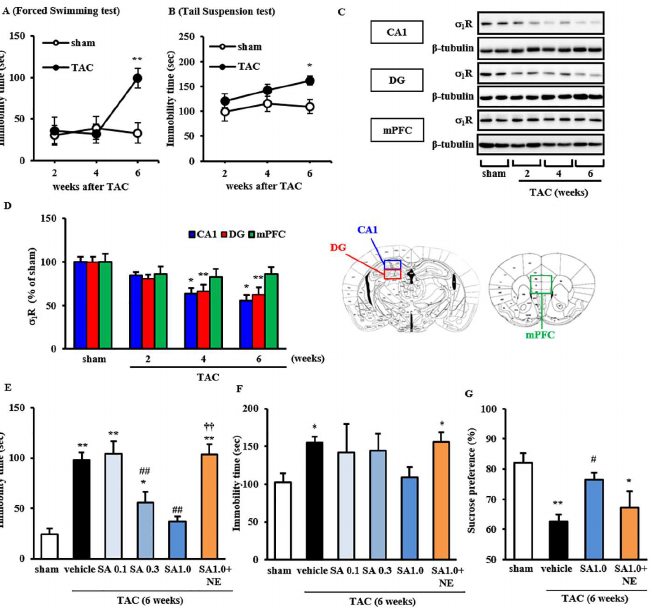
Fig 1. Time course of depressive-like behaviors and σ 1 R expression, and effect of SA4503 treatment on depressive-like behaviors in TAC mice. A: Immobility time in a forced swimming test was measured2, 4 and 6 weeks after TAC surgery. B: Immobility time in a tail suspension test was similarly measured.Groups consisted of 6–8 mice. C: Western blot analysis of σ 1 R and β -tubulin(as a loadingcontrol) proteins in the CA1 region, dentate gyrus (DG) and medial prefrontal cortex (mPFC) of sham and TAC mice. Immunoblotting with anti- β -tubulin antibody indicatesequal protein loading.D: Densitometric quantification of σ 1 R immunoreactivity (n = 6). Columnsrepresent means ± S.E.M. F (3, 20) = 4.875, P < 0.05 (CA1); F (3, 20) = 6.182, P < 0.01 (DG); F (3, 20) = 0.698, P = 0.564 (mPFC). * , P < 0.05 and ** , P < 0.01 versus